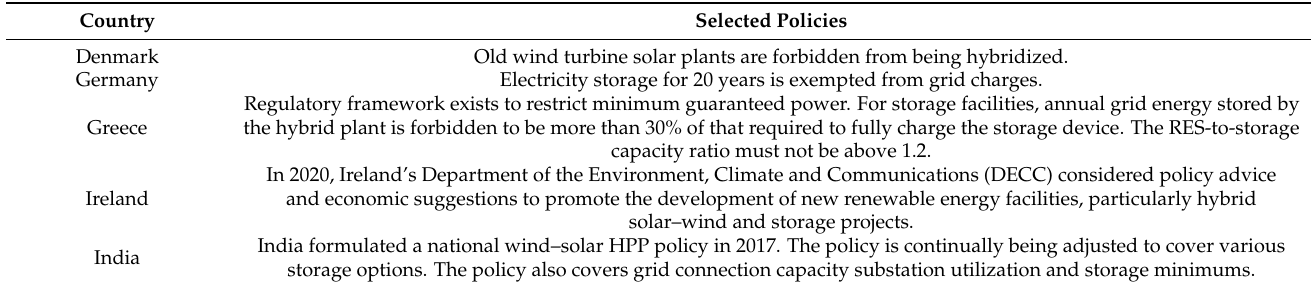
Table 3. Solar–wind hybrid policies in different